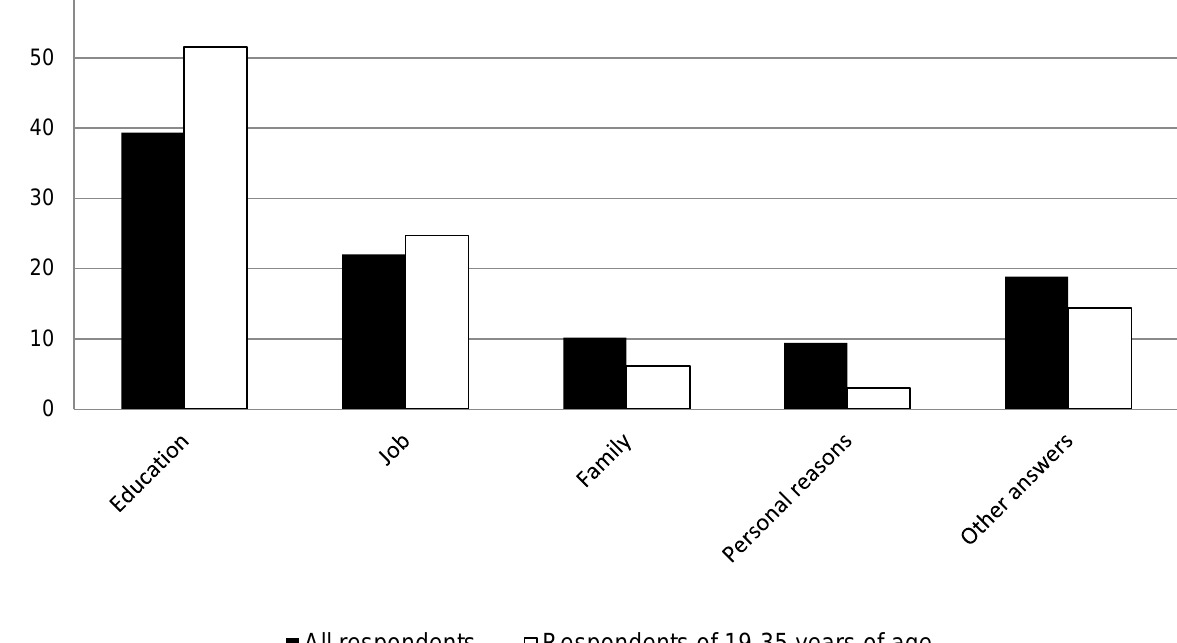
All respondents Respondents of 19-35 years of Figure 2. “What is the main reason why you moved to another municipality?” Percentage distribution of 127 answers from 120 outmigrants and 97 answers from 88 outmigrants of 19-35 years of age, 2011